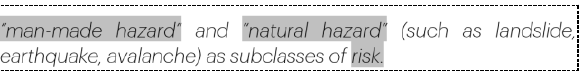
Figure 14. Concepts, relations and properties of hazards.